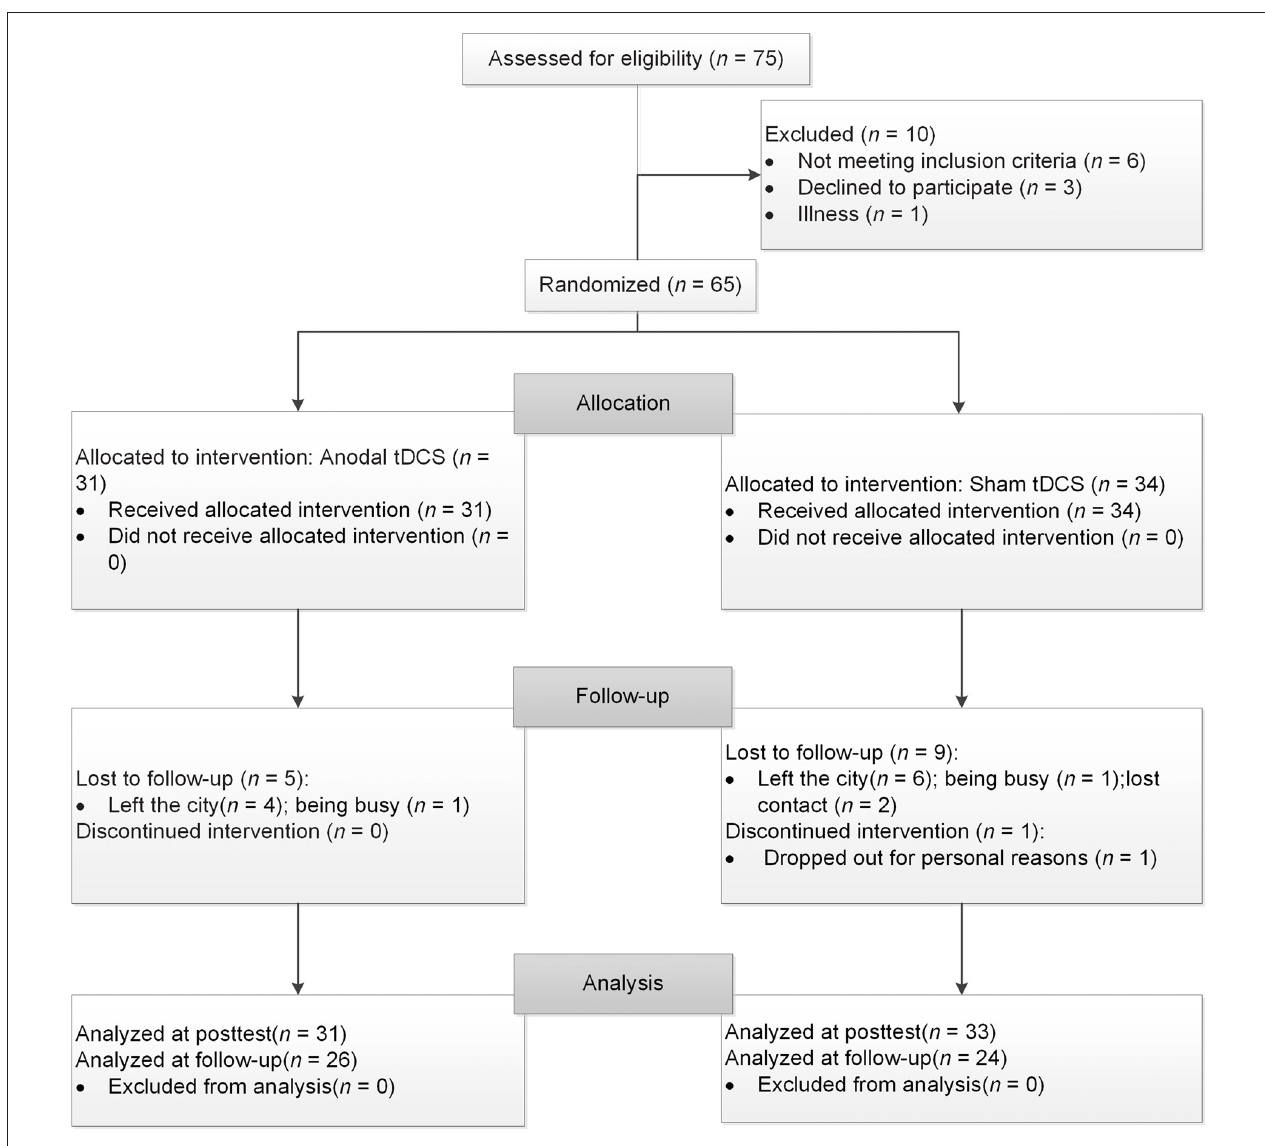
FIGURE 1 | The flow chart of the study. tDCS, transcranial direct current